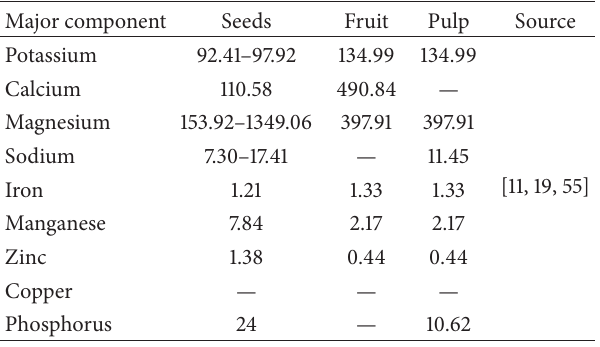
Table 6: Distribution and contents of minerals in the various parts of Z. lotus . Mineral contents are expressed as